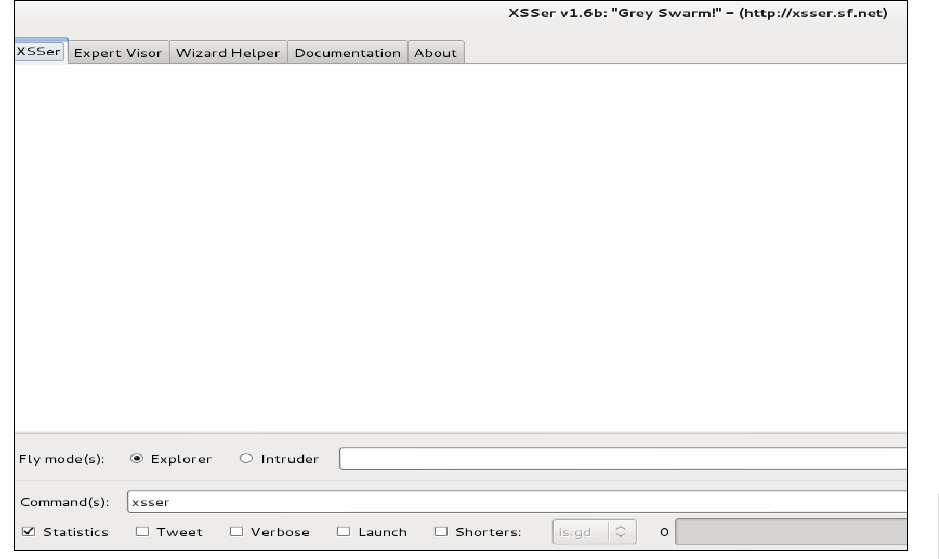
Figure 6 – XSSer – initial screen Рис . 6 – XSSer – Начальный экран Slika 6 – XSSer – po č etni